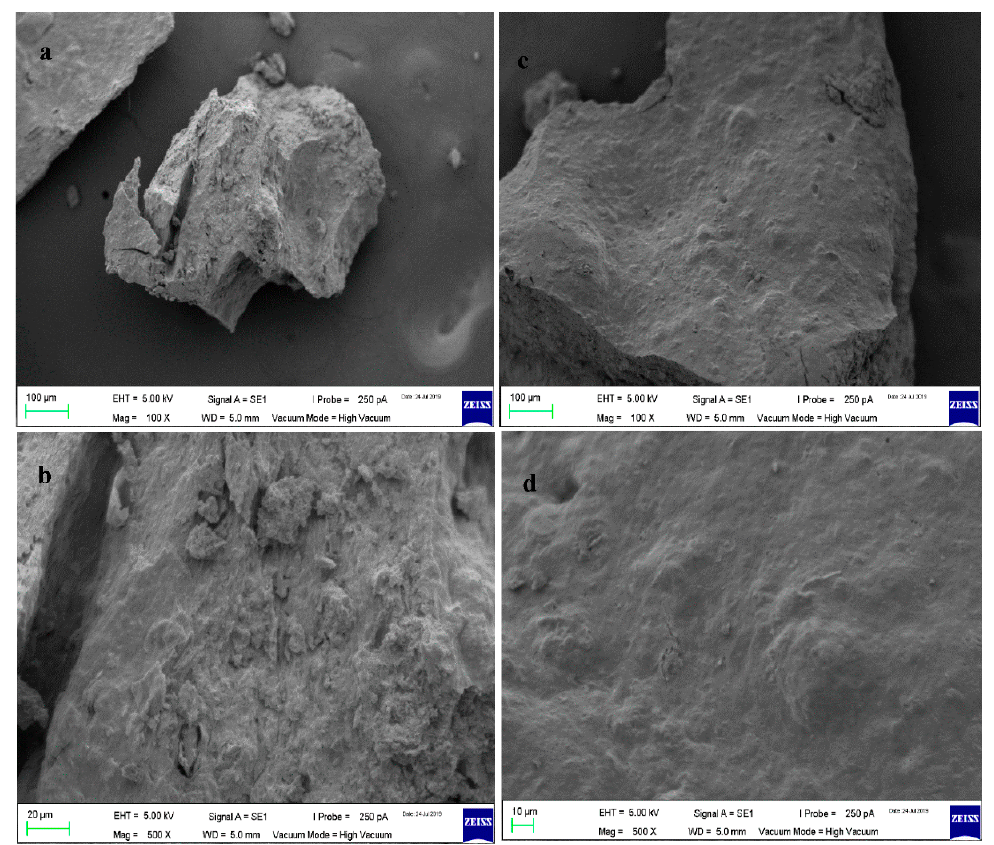
Figure 5. ( a , c ) Magnification of ROBS floc surface. ( b , d ) Magnification of TSCB floc surface.